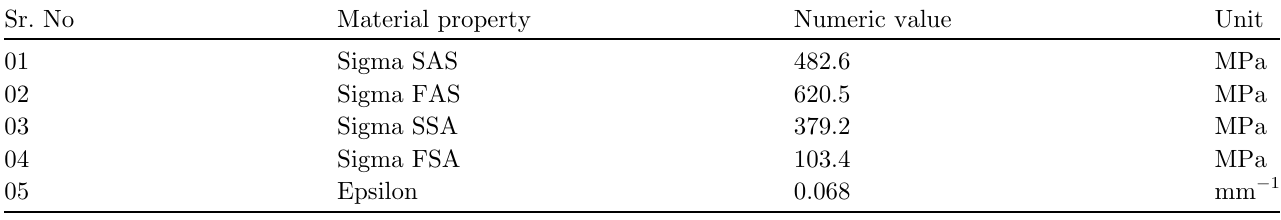
Table 2. Linear elastic properties for nickel-titanium alloy. Sr. No